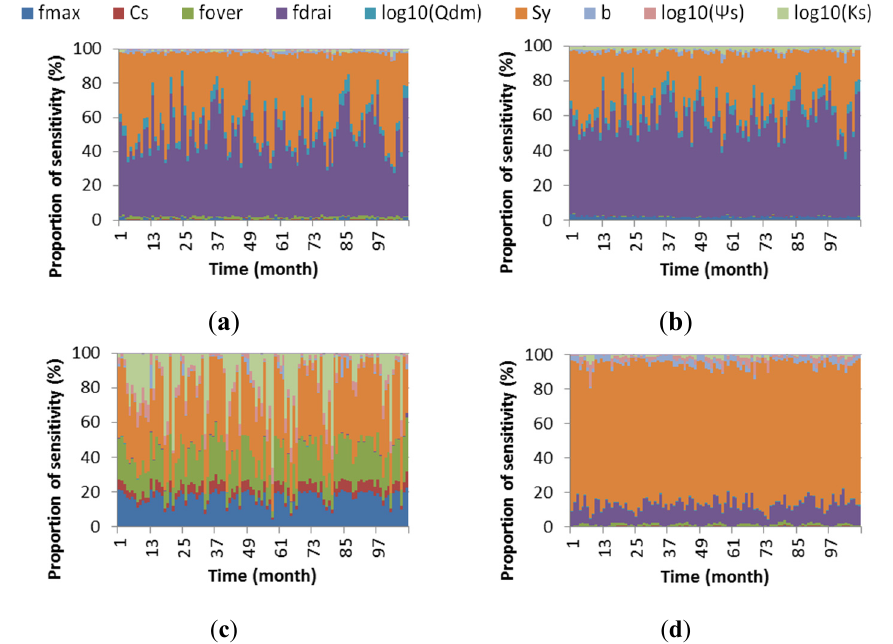
Figure 4. Proportion of sensitivity for residual in 108 months. ( a ) Residual of total runoff (runoff) ANOVA (GLM 1st order); ( b ) Residual of subsurface runoff (qdrai) ANOVA (GLM 1st order); ( c ) Residual of surface runoff (qover) ANOVA (GLM 1st order); ( d ) Residual of latent heat (LH) ANOVA (GLM 1st order).